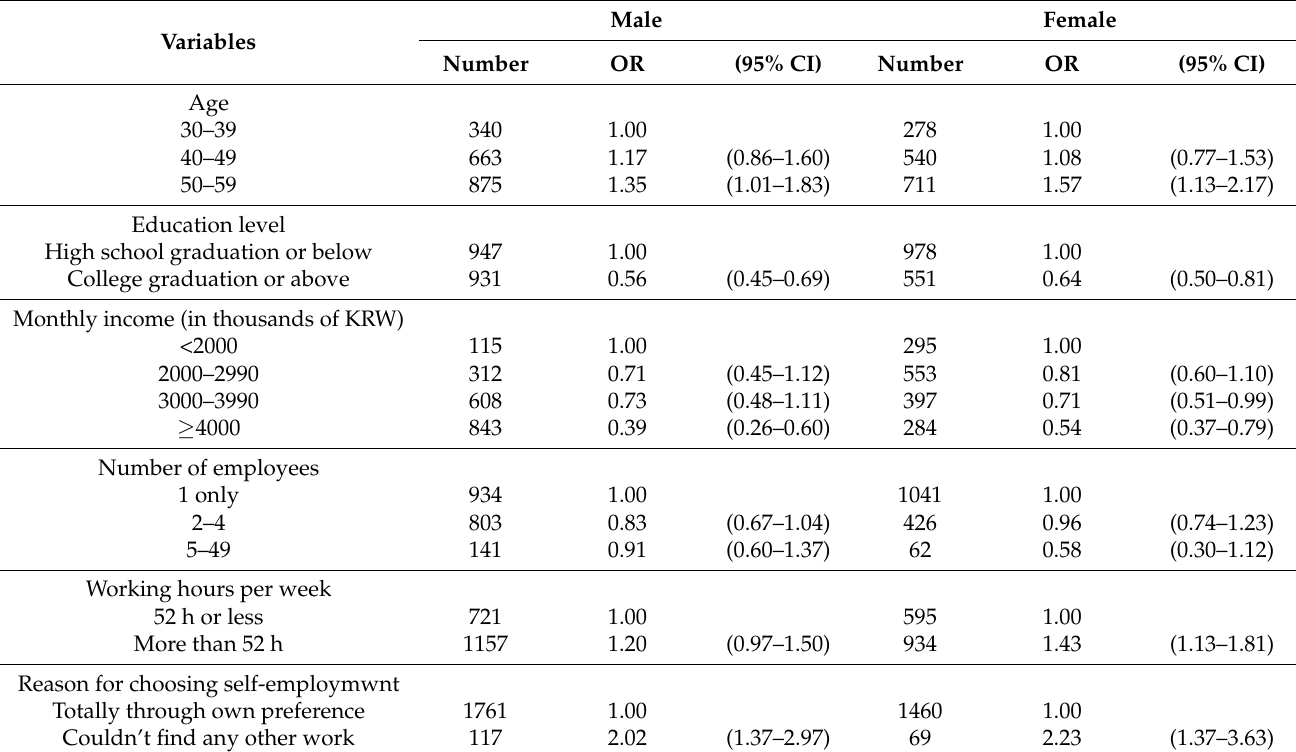
Table 2. Odds ratios for the poor well-being score groups according to associated